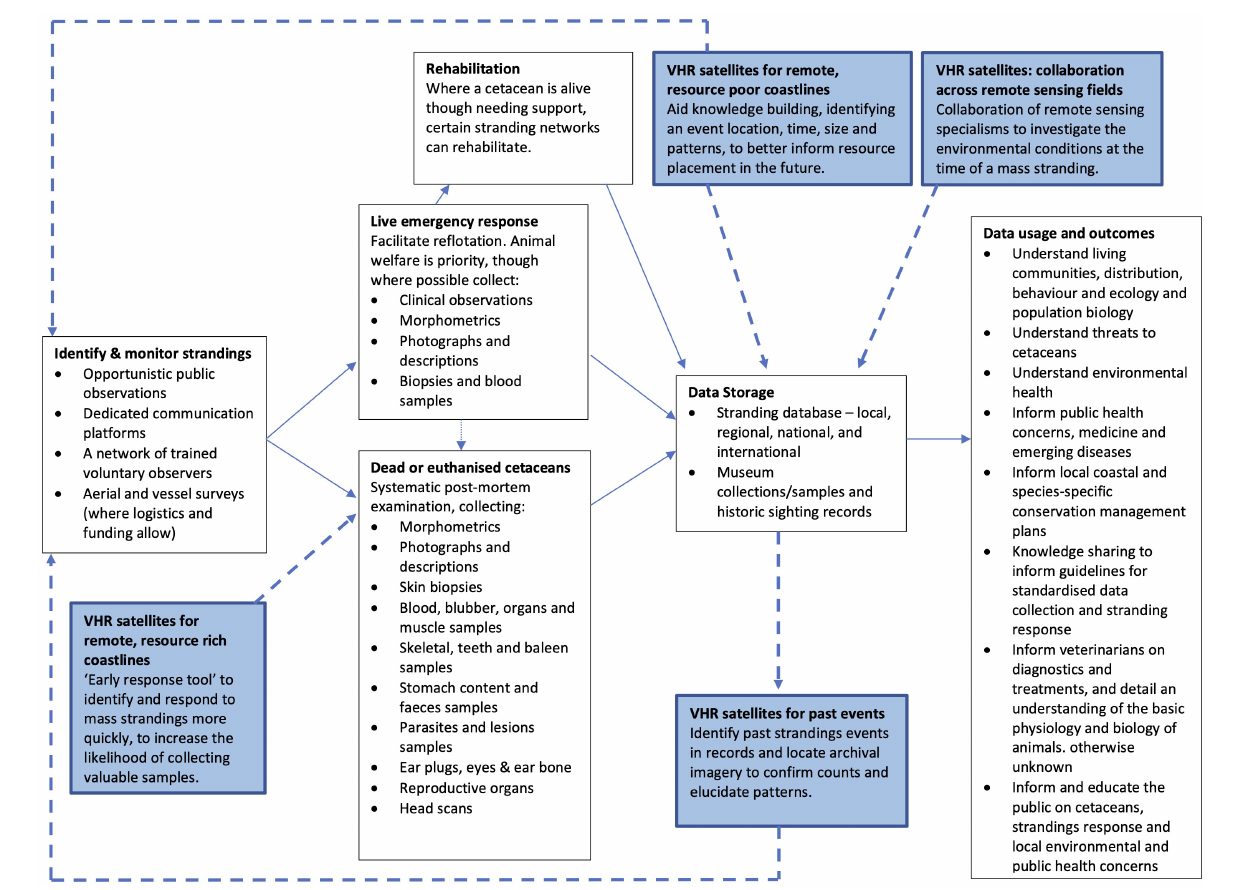
FIGURE 2 | A schema diagram representing how stranding networks monitor strandings (i.e., data collected, what it is used for, and the outcomes), and where/how VHR satellite imagery could assist.